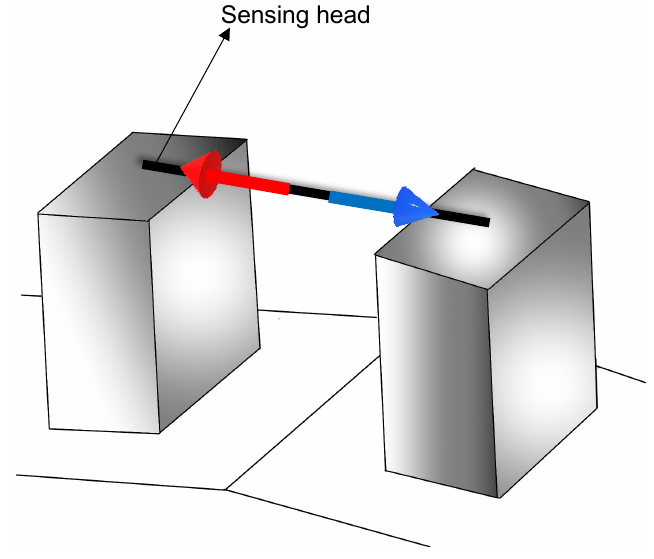
Figure 5. Direction of principal stress.